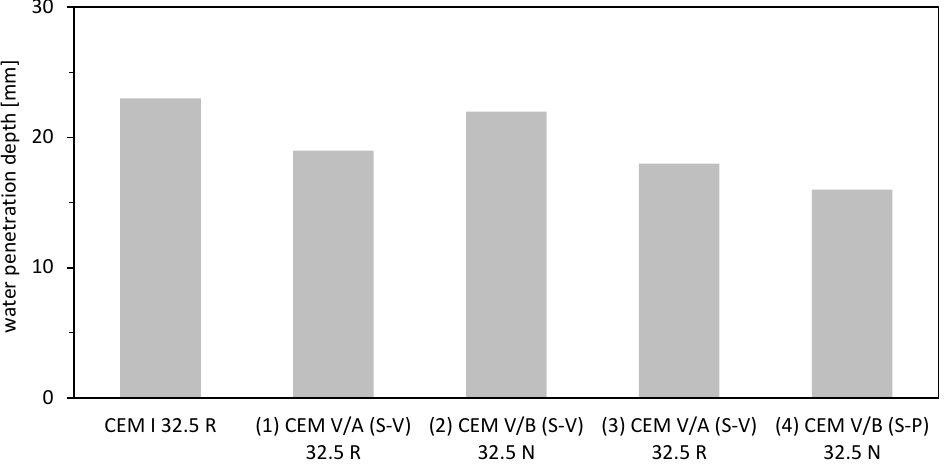
Figure 12. Water penetration depth (in mm) after water pressure test (each value as mean value of 3 individual tests).